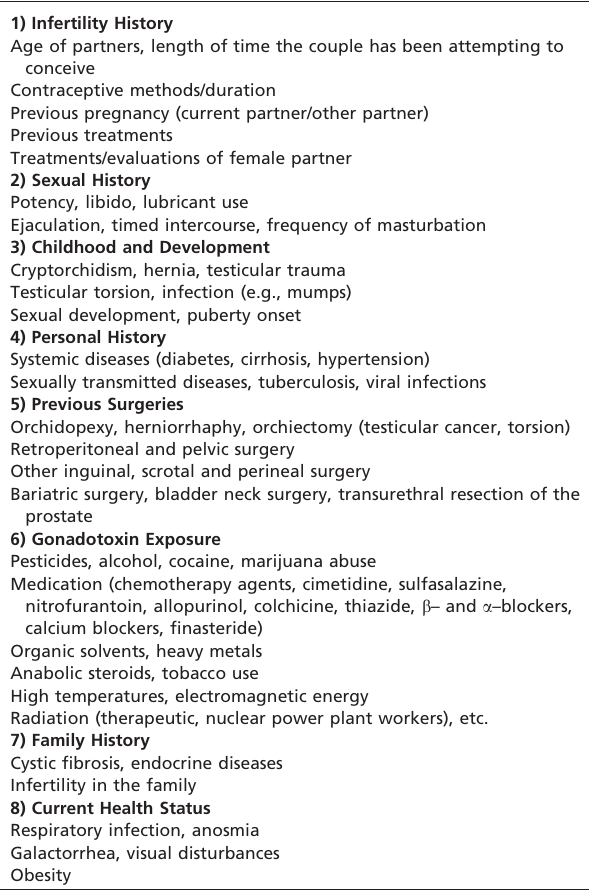
Table 2 - Clinical Male Infertility History